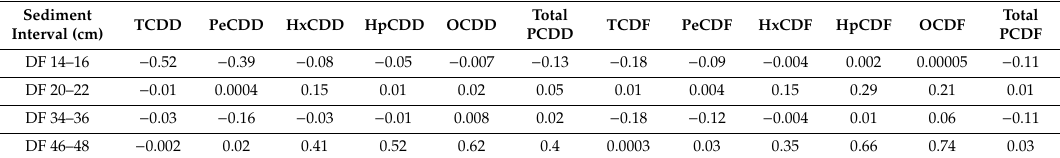
Table 7. Regression co-e ffi cient ( r 2 ) values for dioxin / furan / total homologue concentration (pg / g) versus surface area (m 2 / g). Negative values indicate a negative correlation between the two parameters. The number of size fractions indicates how many data points were used to generate the regression coe ffi cient; r 2 values using four size fractions exclude the > 63 µ m fraction from the calculation, r 2 values using five size fractions include all the fractions.